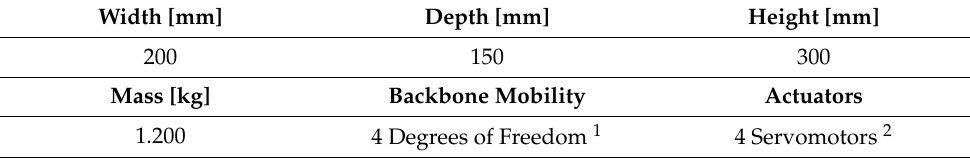
Figure 1. The LARMbot humanoid robot [17,18]: ( a ) Architecture and mobility; ( b ) A prototype.